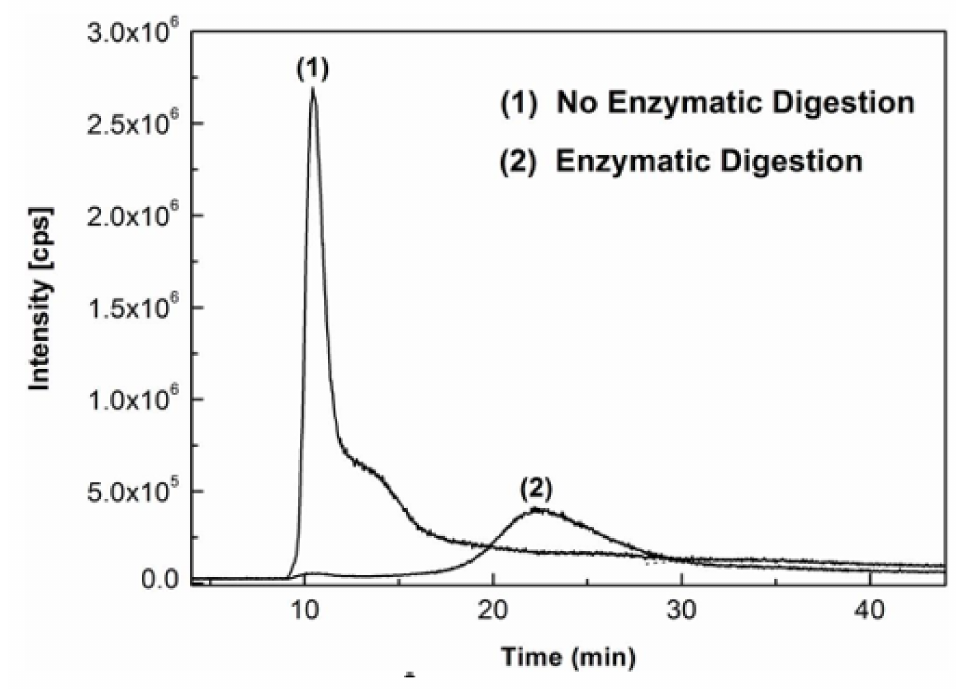
Figure 2. Overlaid AF4-ICP-MS fractograms of AgNPs standard (60 nm) spiked into milk (1) without or (2) with enzymatic